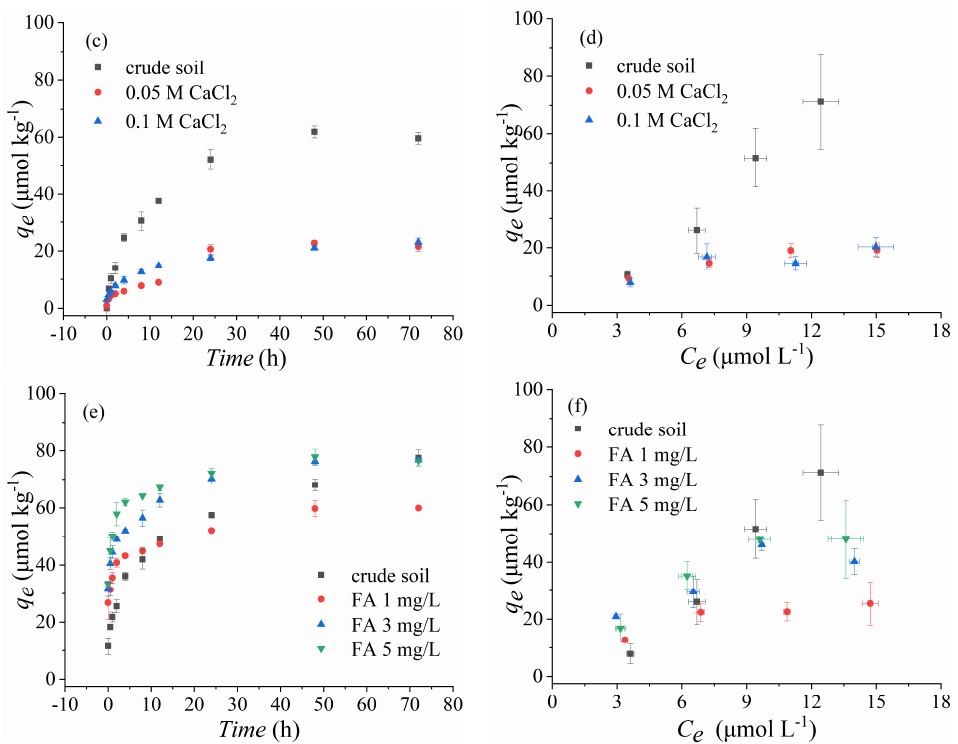
Figure 1. The sorption kinetics ( a , c , e ), and isotherm ( b , d , f ) of SDZ in soil solution with different pH, IC, and DOM conditions.